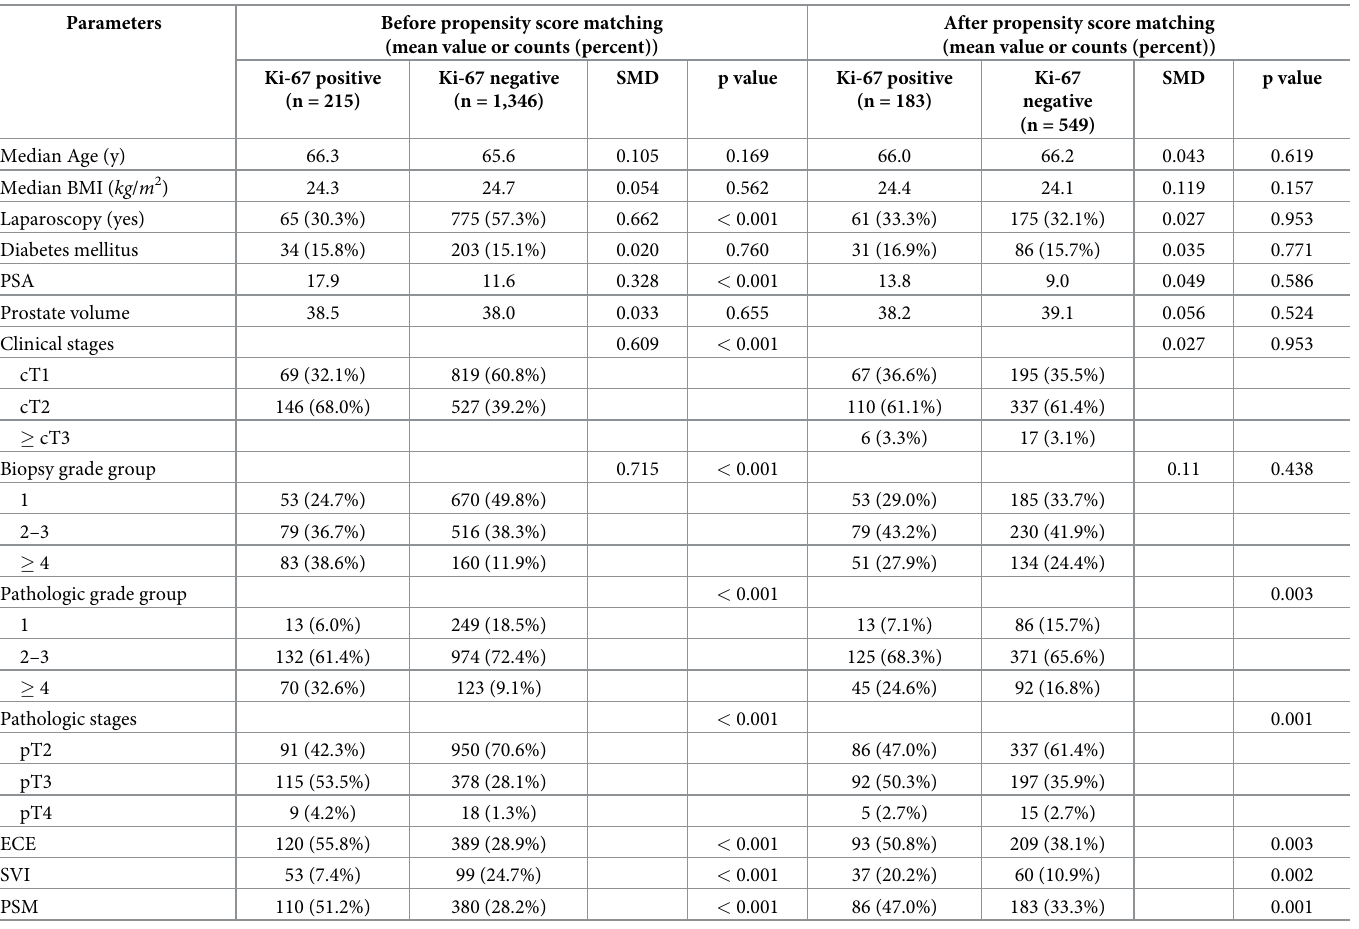
Table 1. Clinical and pathologic characteristics by Ki-67 expression. Parameters